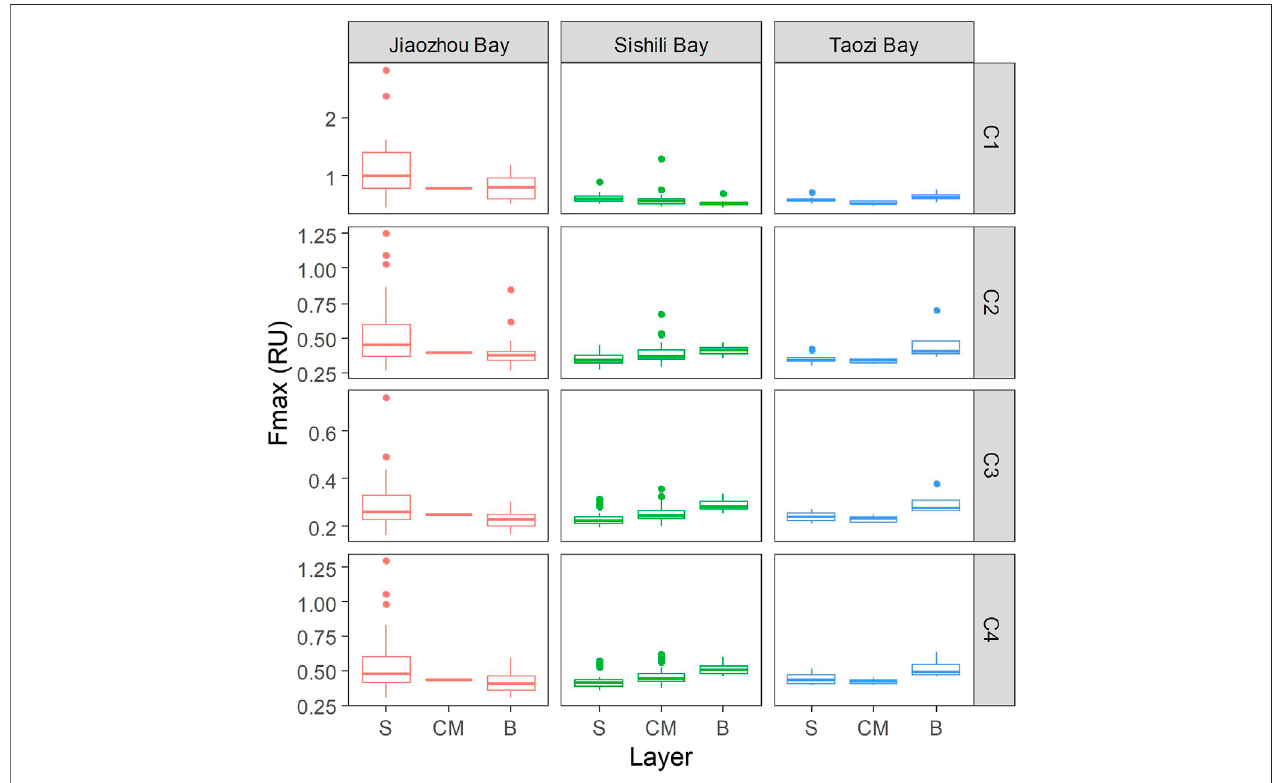
FIGURE 8 | Boxplots of four PARAFAC components in different layers (S, Surface; CM, Chl-a Max; B, Bottom) of three bays (Jiaozhou Bay, Sishili Bay, and Taozi Bay).